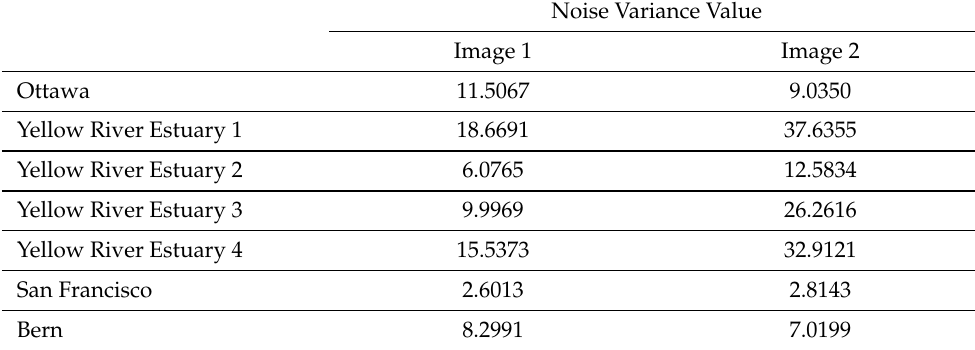
Table 2. Noise Variance